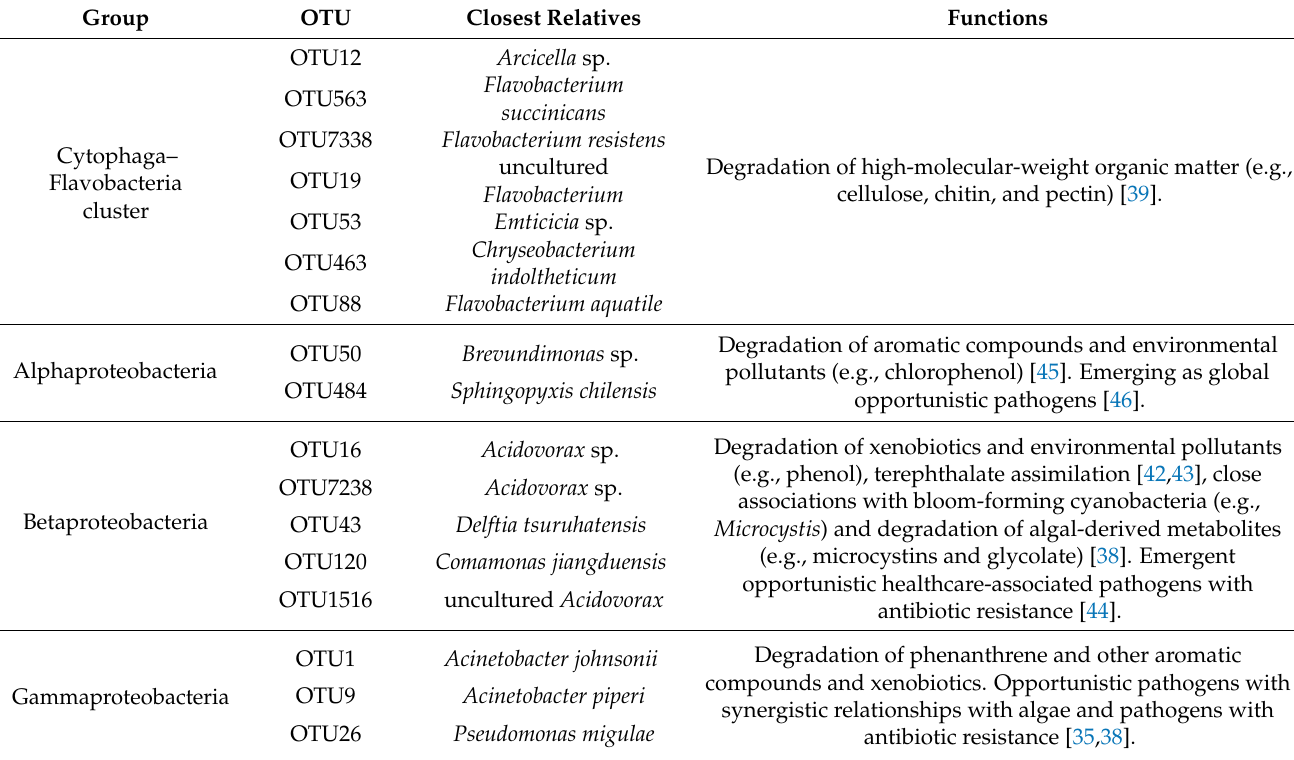
Table 1. Abundant ( ≥ 0.1%) free-living OTUs released in the BA microcosms, associated species, and indicative functions of the major groups or specific members of the